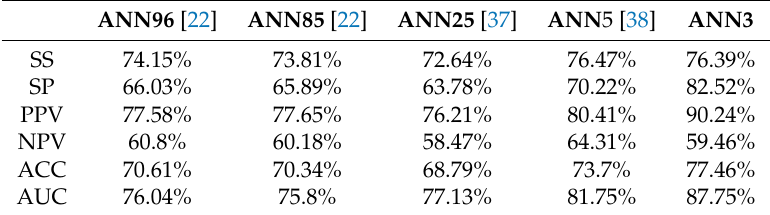
Table 11. Performance indicator versus technique using random subsampling validation with IDF criteria.